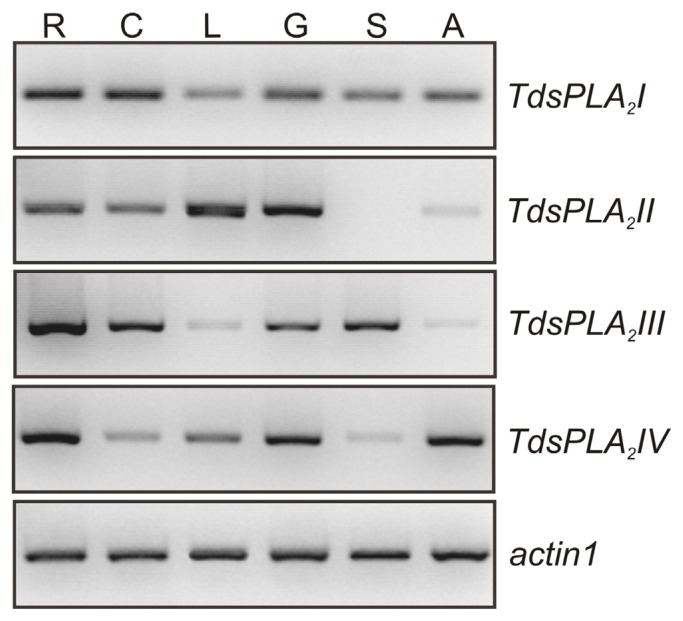
Tissue-specific expression of the TdsPLA2 genes. Representative expression analysis of TdsPLA2I, TdsPLA2II, TdsPLA2III, TdsPLA2IV and actin1 genes carried out by using the specific primer pairs reported in Table 1. The figures of gel separation are presented in inverted colors. R, root; C, culm; L, leaf; G, glume; S, seed; A, awn.